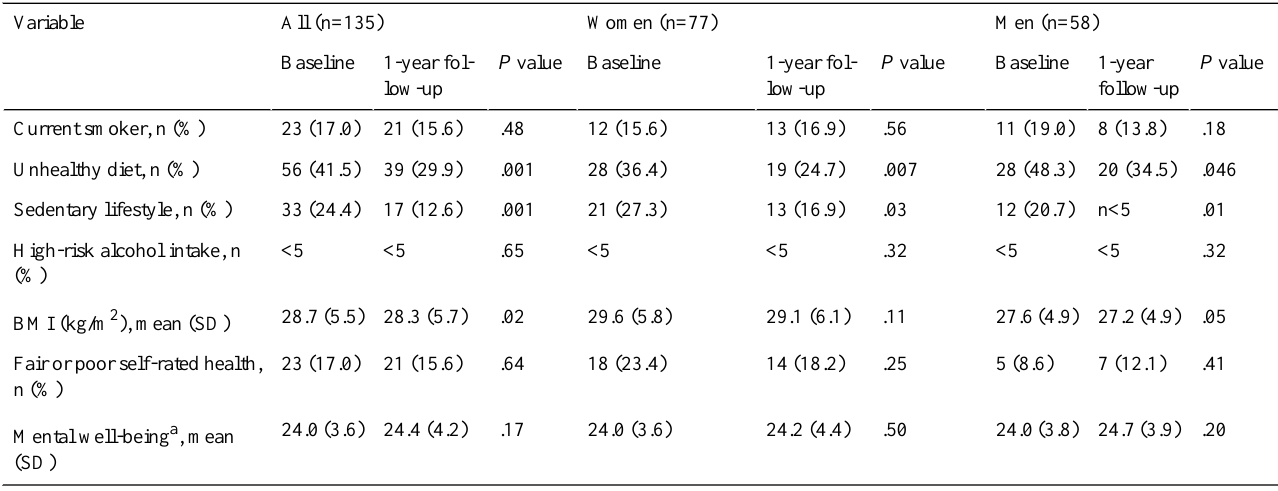
Table 4. Health-risk behaviors, BMI, self-rated health, and mental well-being at baseline and 1-year follow-up among high-risk and health-risk behavior participants who received the digital personal health profile and targeted intervention at their general practitioner or municipal health center.